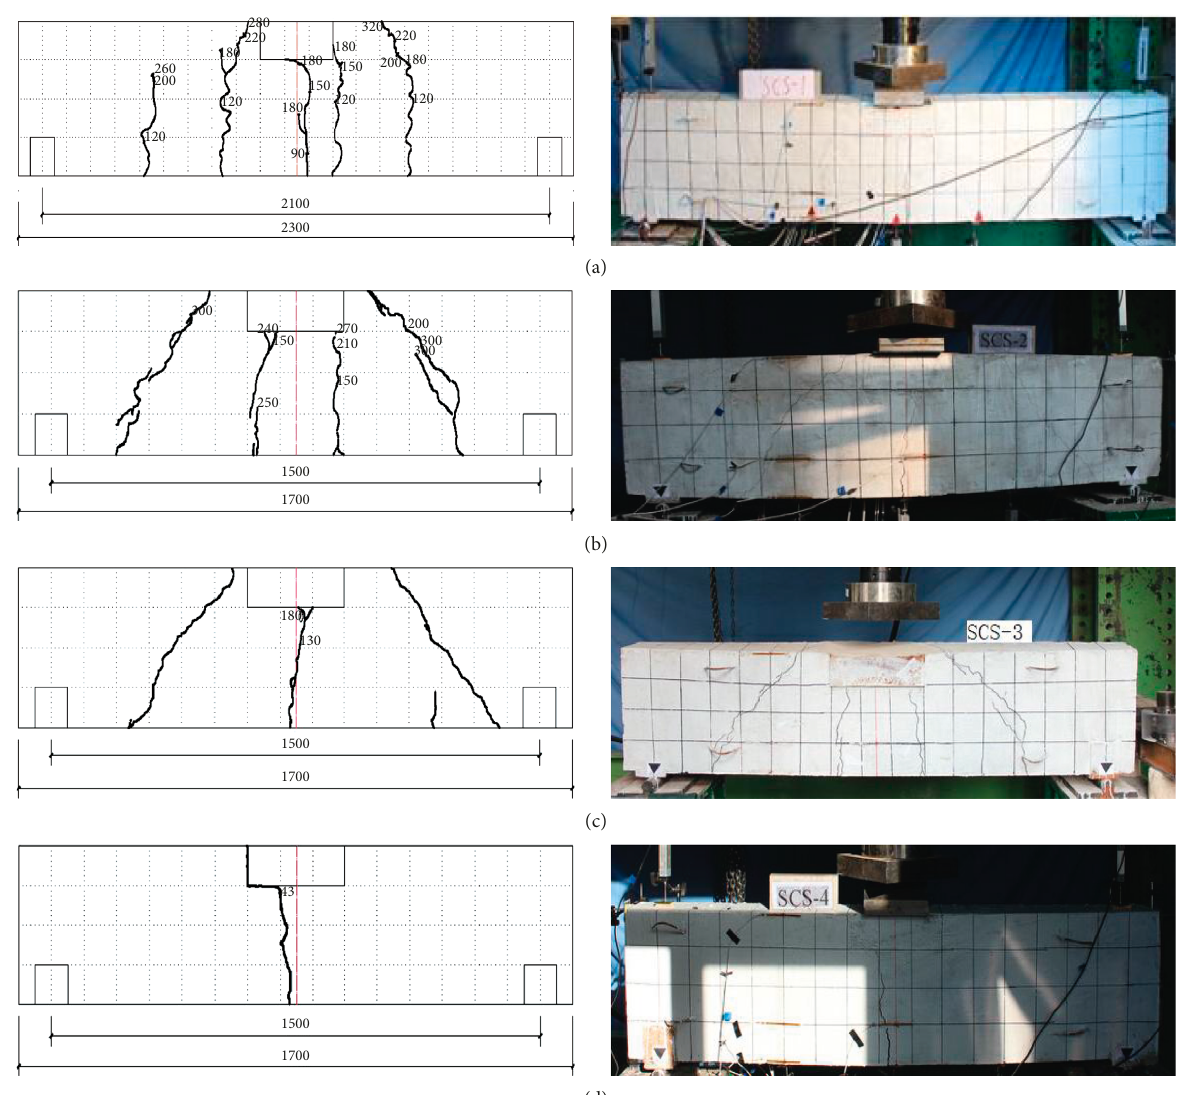
Figure 5: Crack pattern of steel plate-concrete composite slabs. (a) Crack pattern diagram for SCS-1 ( λ � 2 . 63). (b) Crack pattern diagram for SCS-2 ( λ � 1 . 88). (c) Crack pattern diagram for SCS-3 ( λ � 1 . 88). (d) Crack pattern diagram for SCS-4 ( λ � 1 .